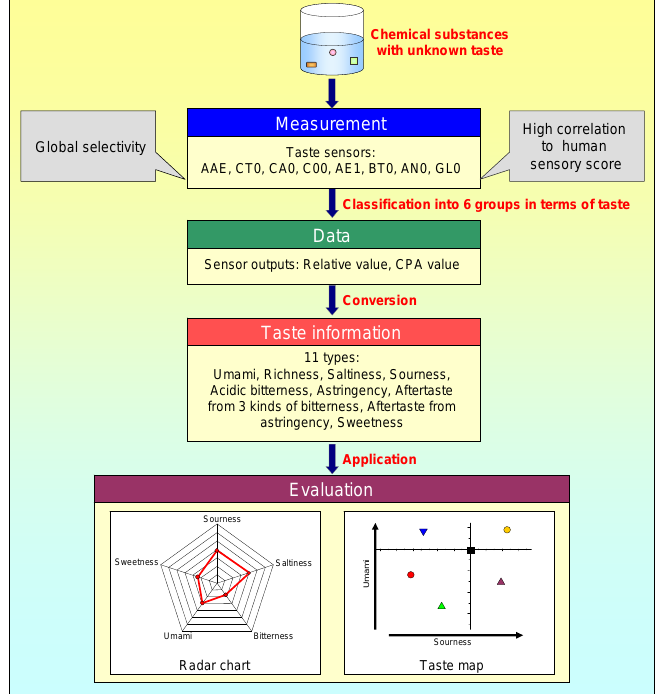
Figure 14. Flowchart from measurement to evaluation using taste